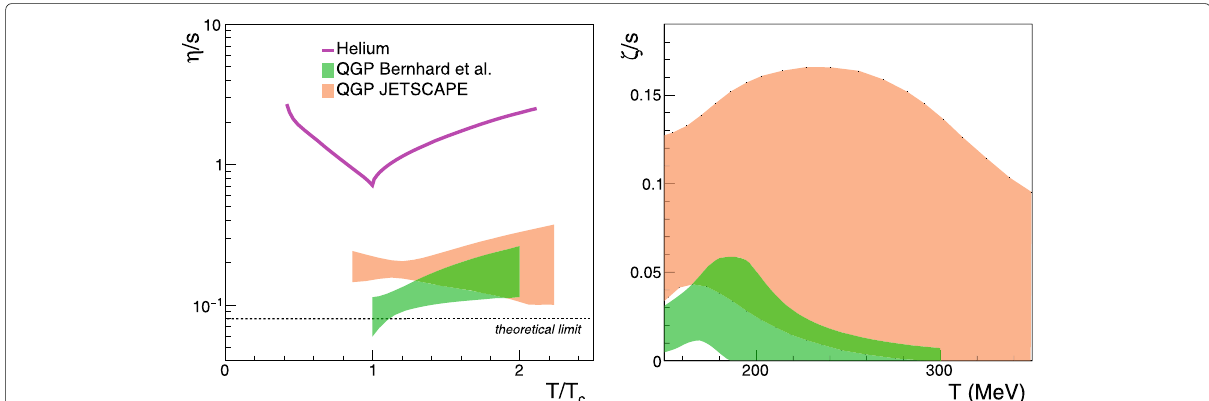
Fig. 9 Estimated temperature-dependent specific shear (left) and bulk (right) viscosities of the QGP using Bayesian method [51, 52]. The shaded bands show 90% credible region for the QGP η/ s ( T ) and ζ/ s ( T ) estimated from experimental data. The green bands are from Ref. [51] and the orange bands from Ref. [52]. The pseudo-critical temperature T c = 156.5 ± 1.5 MeV [2] for a crossover phase transition from the QGP to hadronic matter is assumed. Solid line shows η/ s ( T ) for helium relative to its critical temperature and dashed line for theoretical lower limit [50]